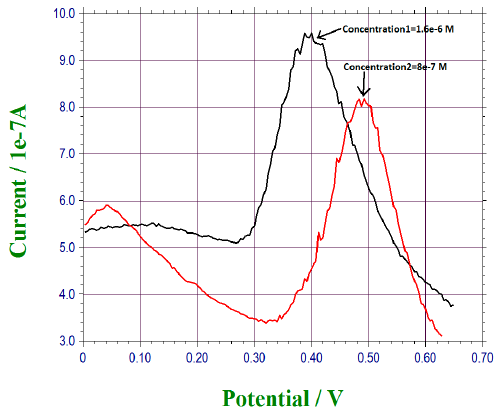
Figure 7. DPV measurement of lead concentration levels of 1.6 × 10 − 6 M and 8 × 10 − 7 M.